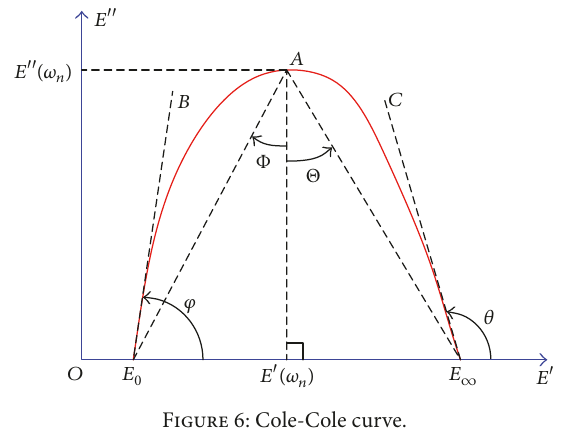
Figure 7: Acceleration response curve of the power module under harmonic